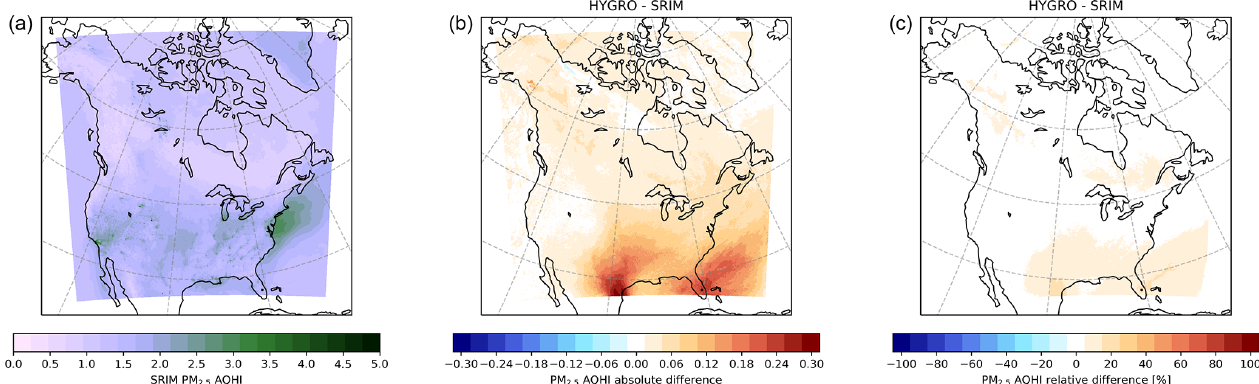
Figure 3. (a) Mean PM 2 . 5 AQHI values from the SRIM simulation, (b) mean difference in PM 2 . 5 AQHI values between the HYGRO and SRIM simulations, and (c) relative difference in mean PM 2 . 5 AQHI values between the HYGRO and SRIM simulations. Note that PM 2 . 5 AQHI values are nearly identical in the HYGRO and 1L2B simulations.